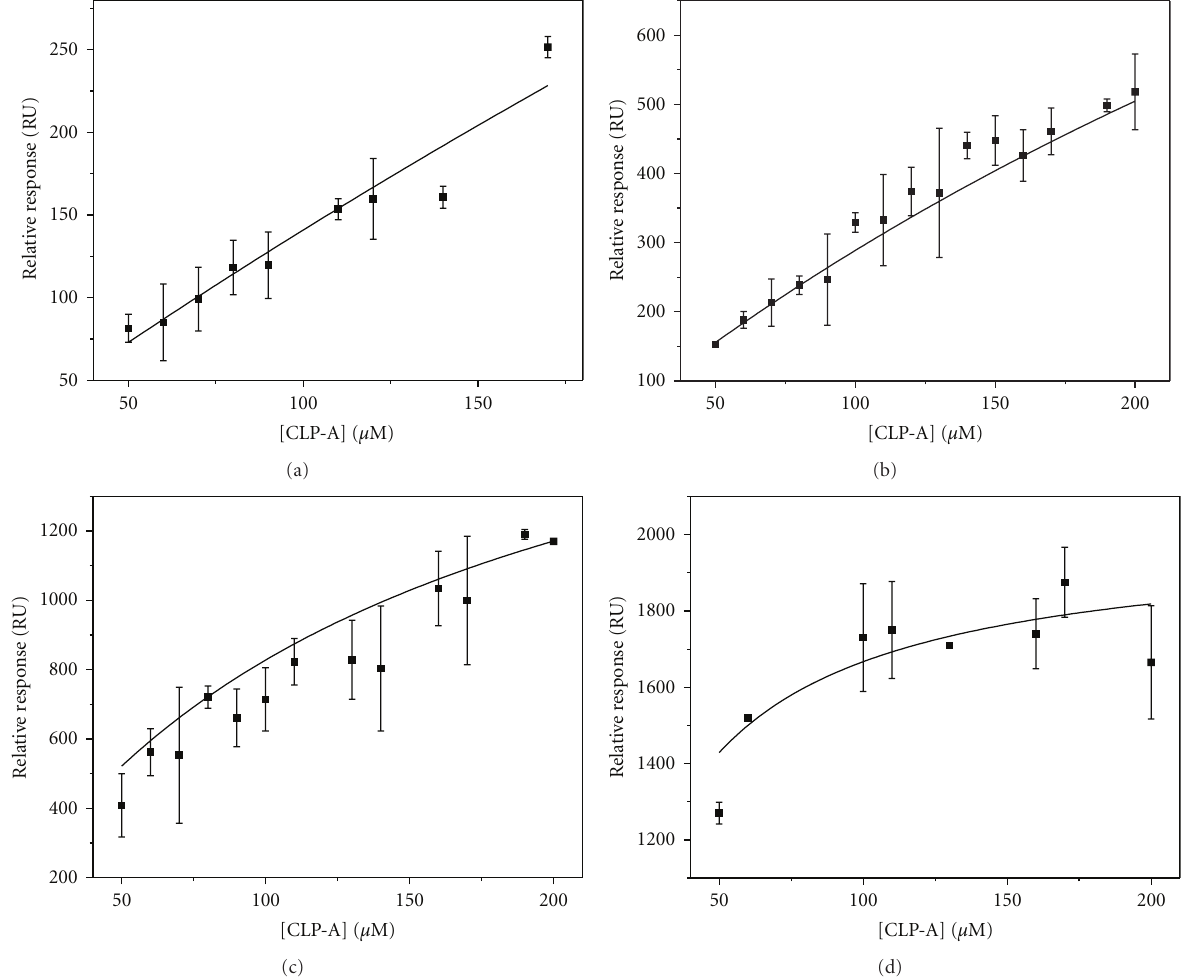
Figure 3: Dose-response curves of CLP-A (50–250 μ M) binding to HSA at (a) 20 ◦ C, (b) 25 ◦ C, (c) 30 ◦ C, (d) 37 ◦ C. Curves were curve-fitted with (2) to obtain K a of the interaction. Error bars are the standard deviation taken from 3 measurements.